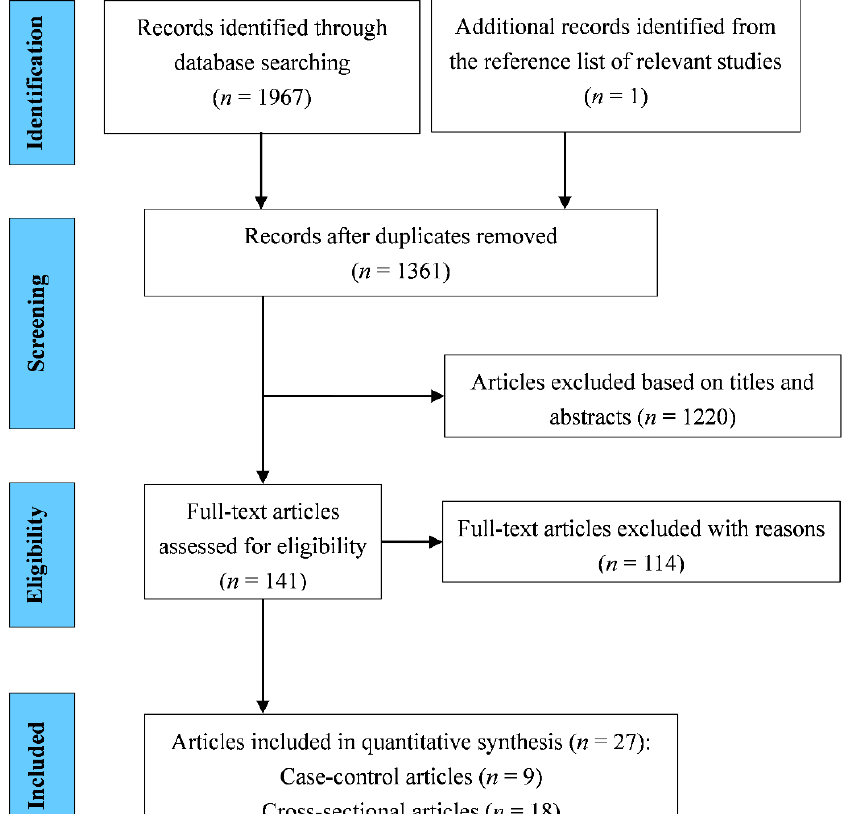
Figure 1. Strategy for literature search and selection.